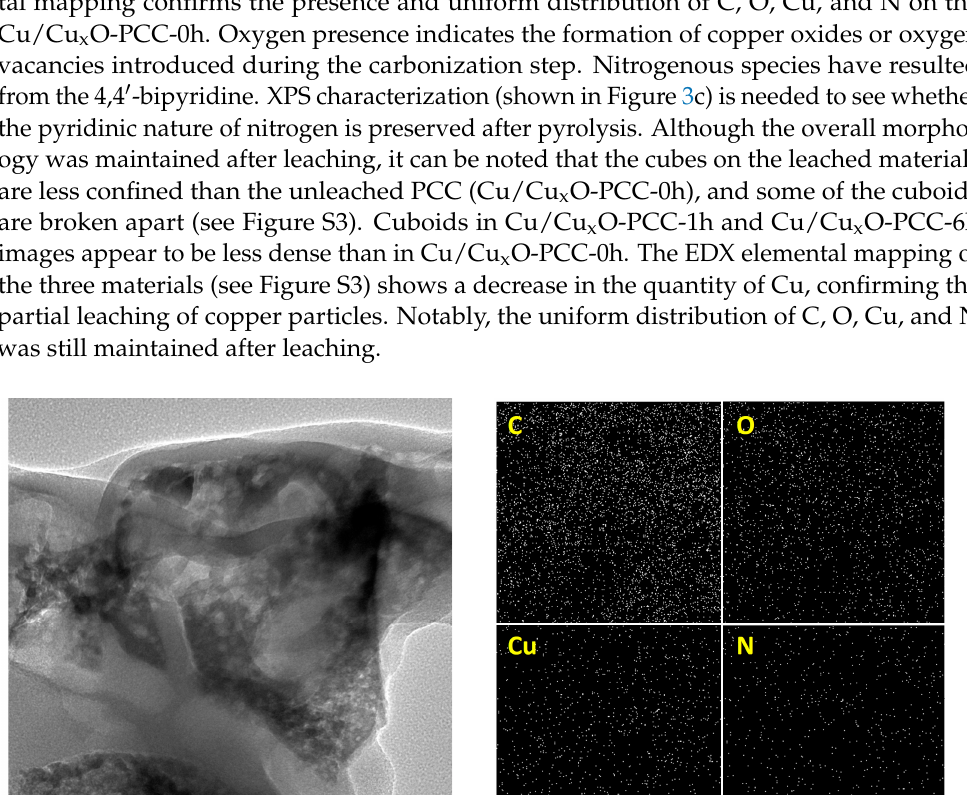
Figure 1. ( a , b ) SEM images of the unleached PCC at different magnifications, ( c ) TEM image of two overlapping cuboids, ( d ) HRTEM demonstrating lattice fringe of a copper particle, ( e ) HRTEM im- age of one Cu nanoparticle.